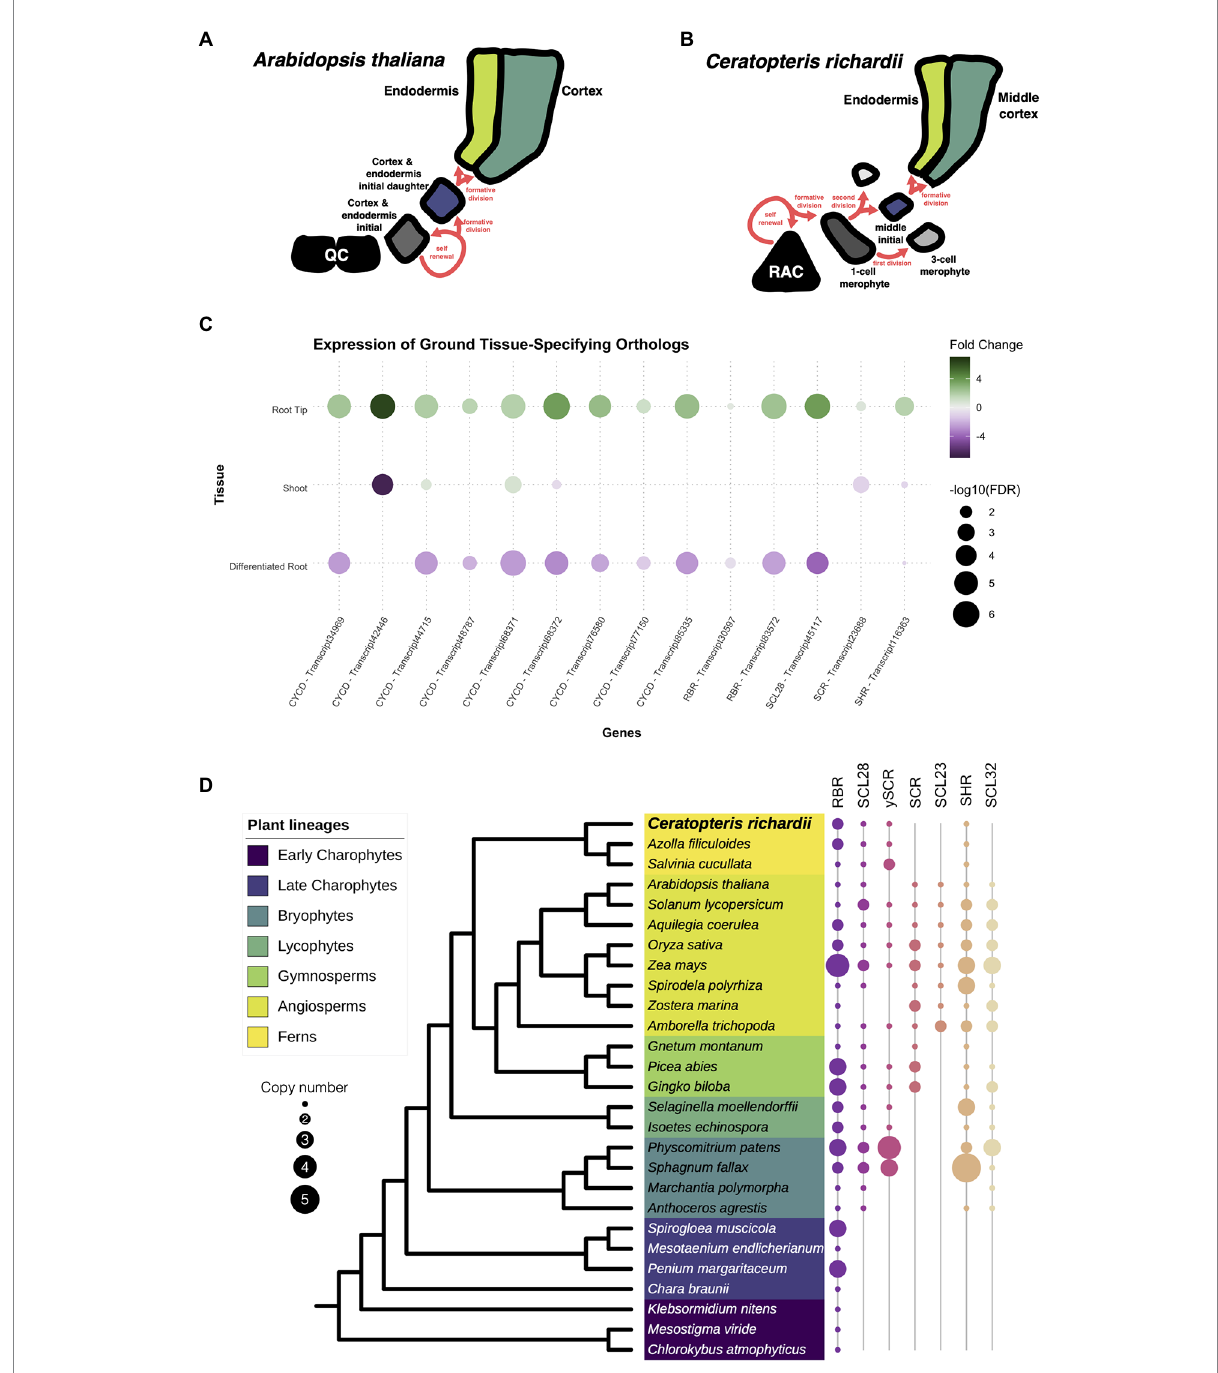
FIGURE 5 Conservation of genes involved in the specification of the ground tissue. (A,B) Schematic representation of the development of the cortex and endodermis between Arabidopsis and Ceratopteris. (C) Expression of Ceratopteris ortholog genes implicated in the cortex-endodermis specification in the different segments. (D) Schematic representation of the presence and absence of orthologs for RBR, SCR, and SHR throughout plant